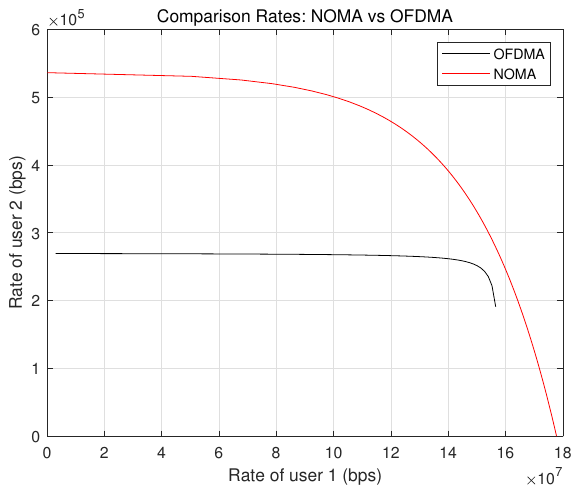
Figure 10. The boundary rate between NOMA and OFDMA for downlink.